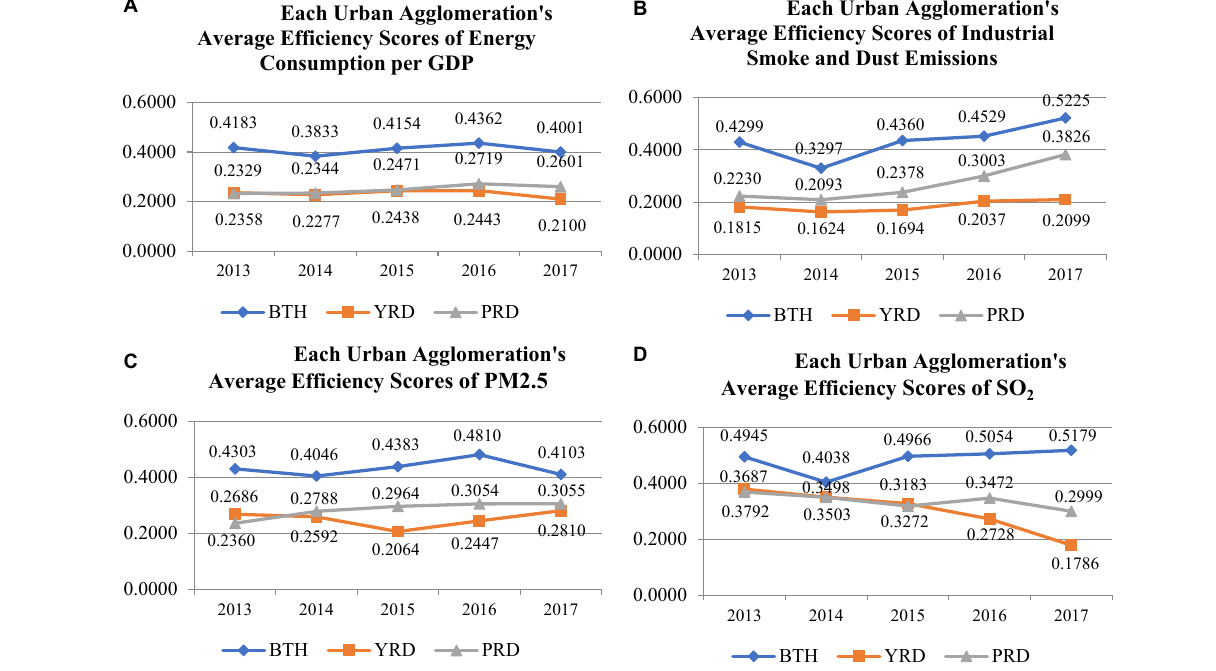
TABLE 7 | Friedman test score of total efficiency. Year Ave rage score of BTH Ave rage score of PRD Ave rage score of YRD Friedman test score